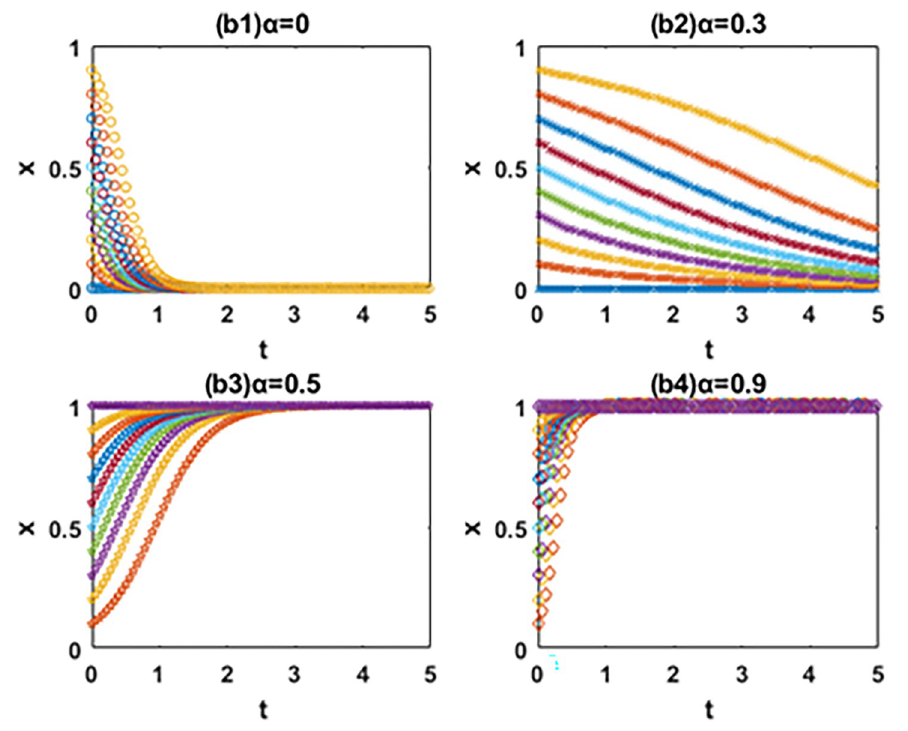
Fig 7. Effects of α on the path selection of the leader enterprise